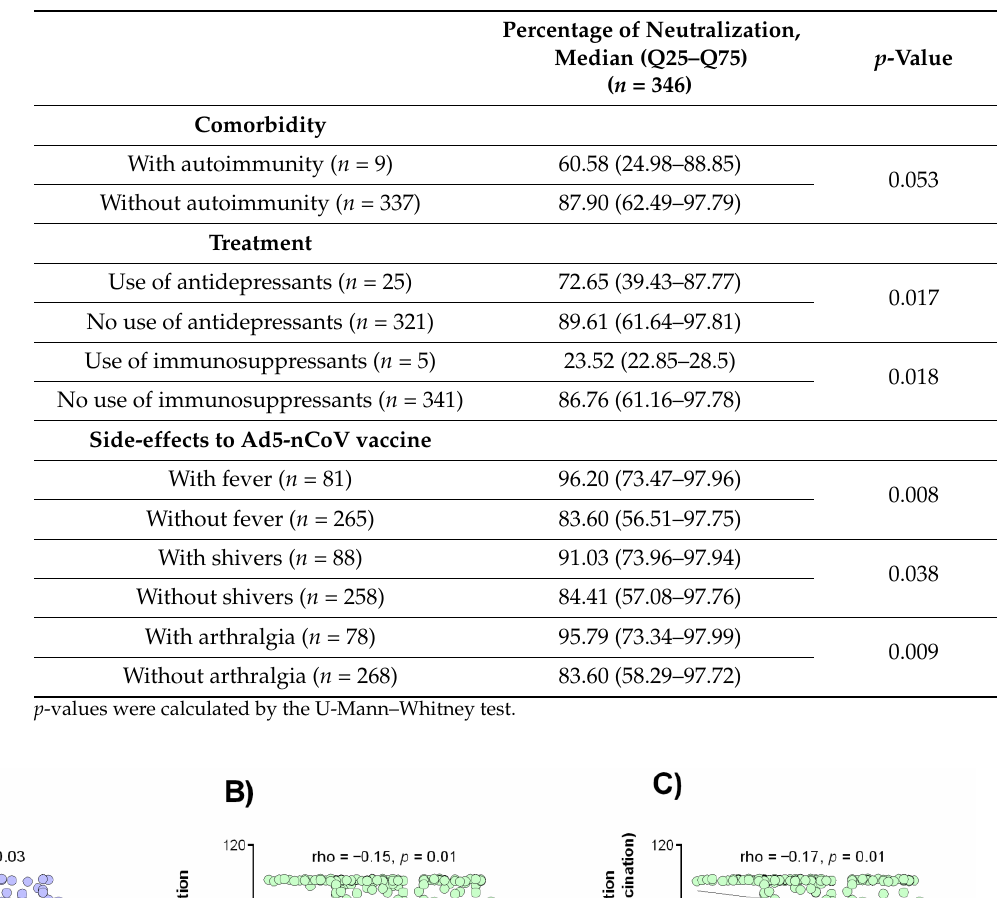
Table 3. Factors associated with the percentage of neutralization after vaccination.